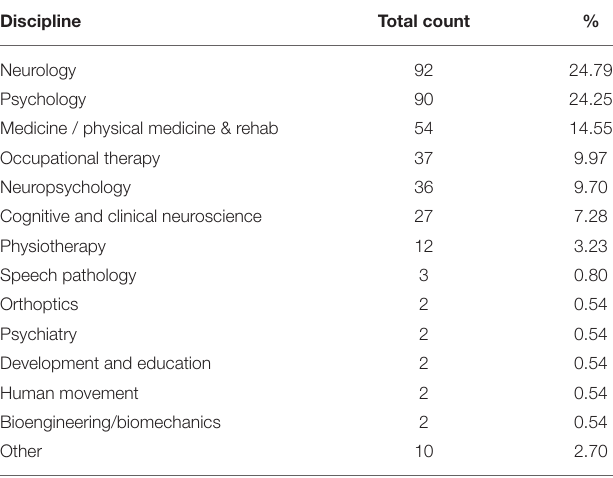
TABLE 2 | Discipline of first author of included